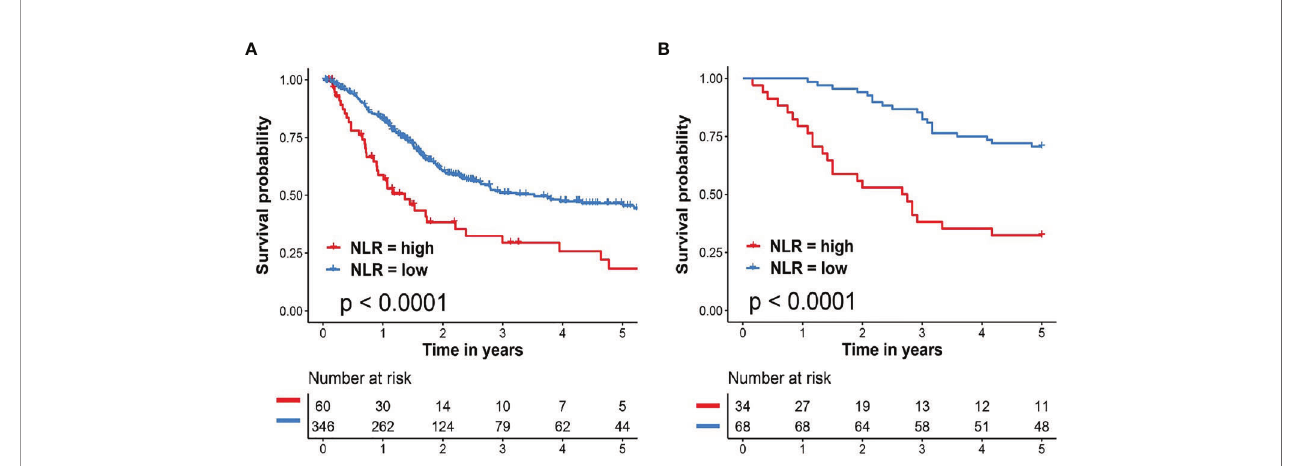
FIGURE 3 | Important role of NLR in clinical prognosis of patients with BCa. (A) Kaplan – Meier survival analysis of overall survival predicted by NLR for BCa patients in the TCGA cohort. (B) Kaplan – Meier survival analysis of overall survival predicted by NLR for BCa patients in the validation cohort (General cohort). BCa, bladder cancer; TCGA, The Cancer Genome Atlas; NLR, neutrophil to lymphocyte ratio.